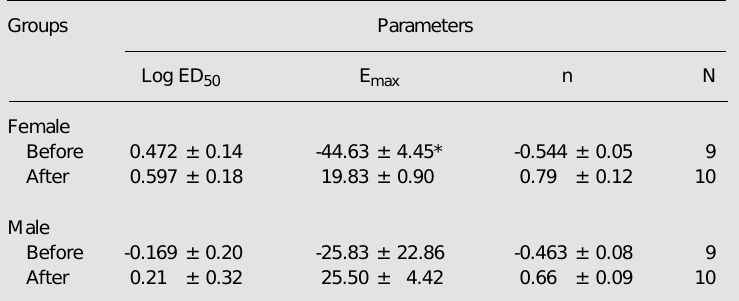
Table 3. Dose-response parameters for 5-HT-induced coronary vasodilation in hearts obtained from naive male and female rats before and after endothelial denudation.